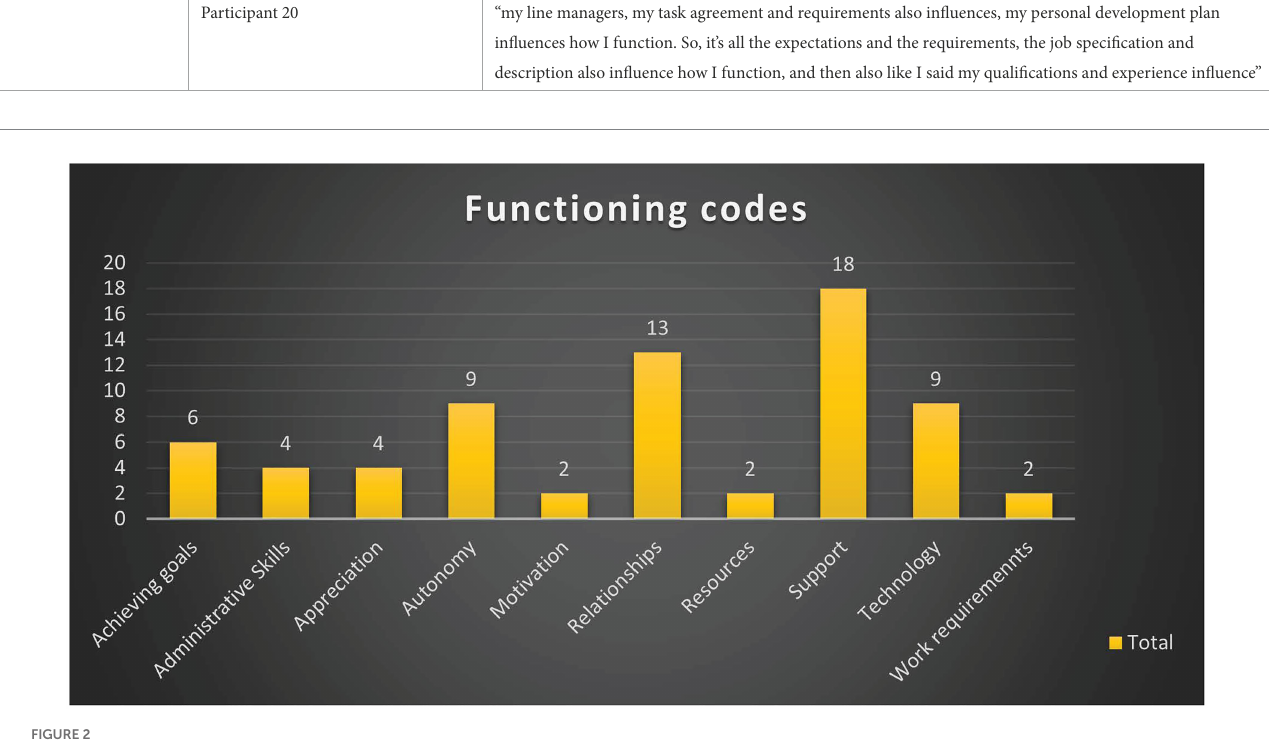
FIGURE 2 Functioning